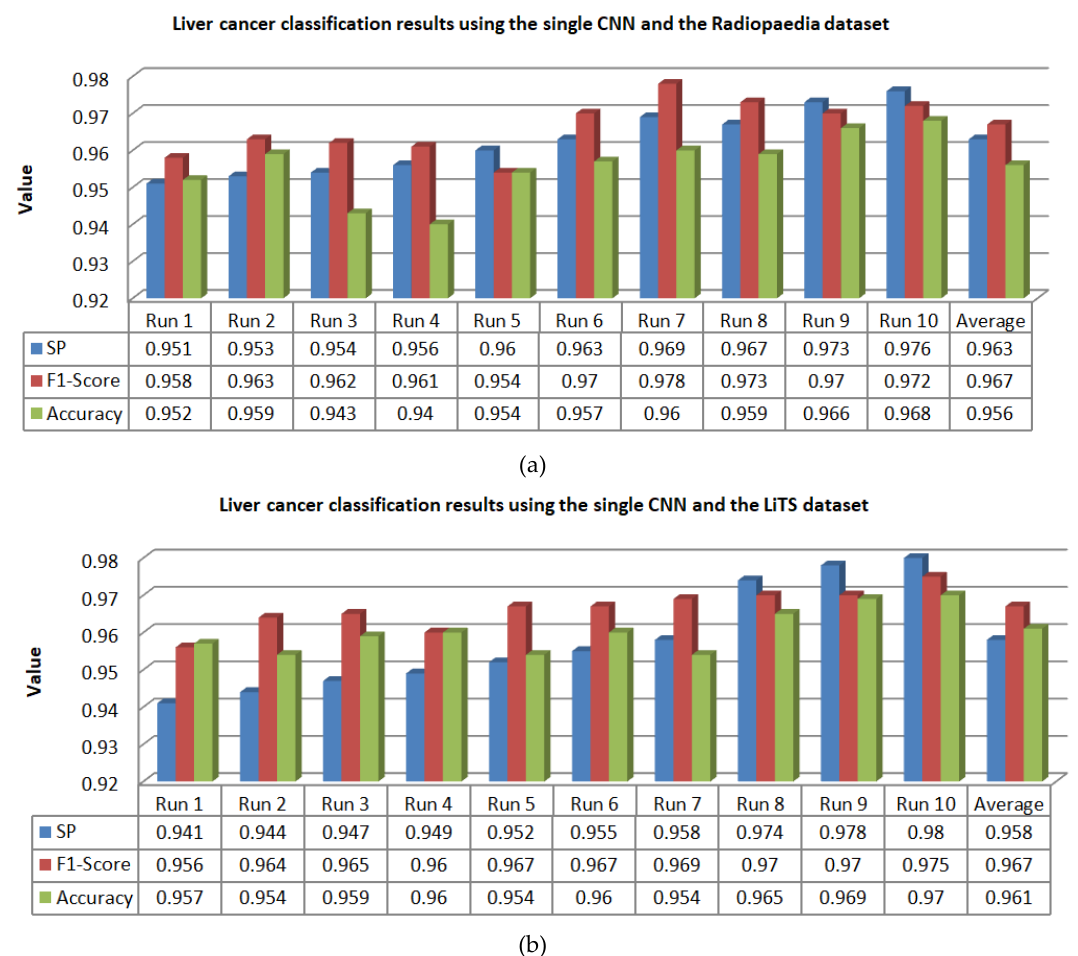
Figure 14. Classification results of liver lesions obtained using the single CNN algorithm, in terms of specificity (SP), F1-score, and accuracy. Results are demonstrated using the ( a ) Radiopaedia dataset and ( b ) LiTS dataset.